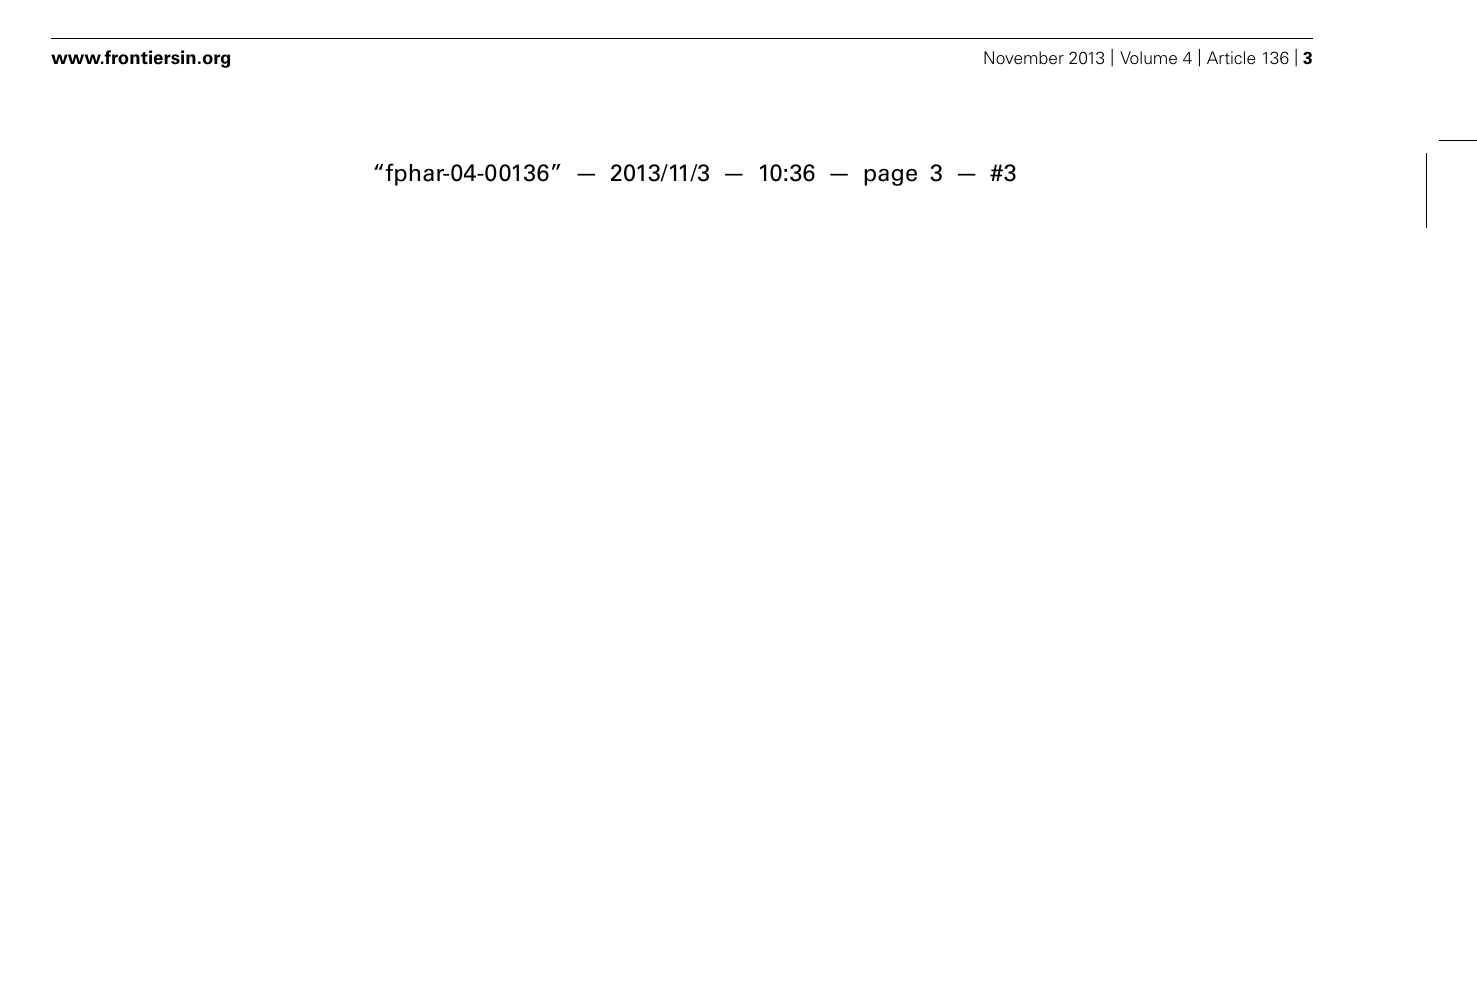
FIGURE 1 | (A) Representative images of the co-localized expression of P-gp (red) in a capillary in normal brain (top row) and a blood vessel in a 231Br brain metastasis (bottom row) are shown. Endothelial nuclei as well as the nuclei of the 231Br lesions are shown in blue (DAPI). Blood vessels (CD-31 expression)